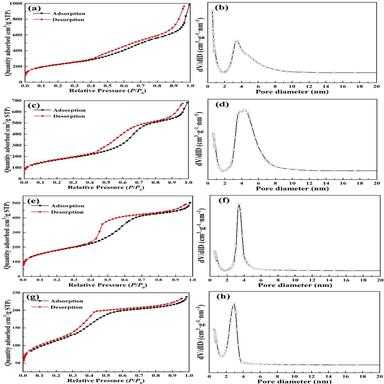
Nitrogen adsorption-desorption isotherms and pore-size distributions of (a, b) D-mSiO2-45, (c, d) D-mSiO2-60, (e, f) D-mSiO2-75, (g, h) D-mSiO2-90 samples.